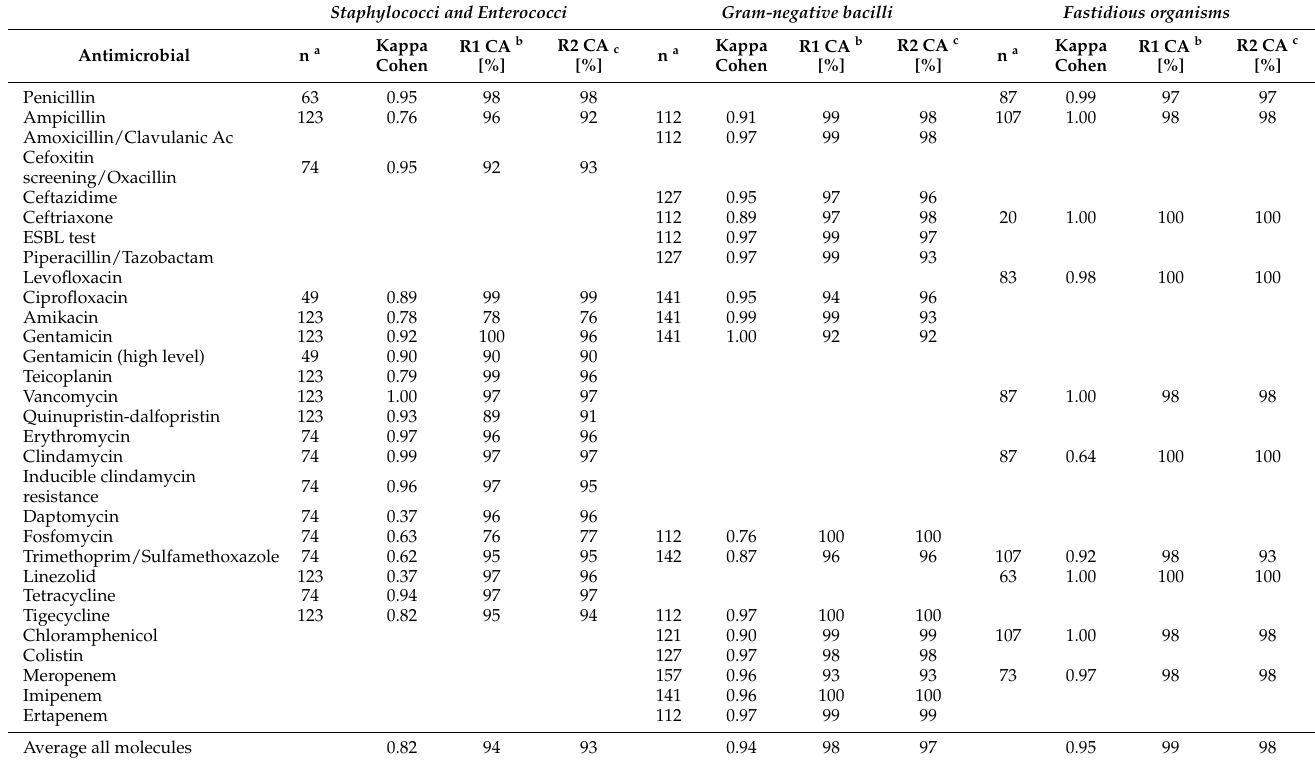
Table 9. Results of the inter-observer variability test using MSF MIC panels with the Prompt inocula- tion method versus the standard AST